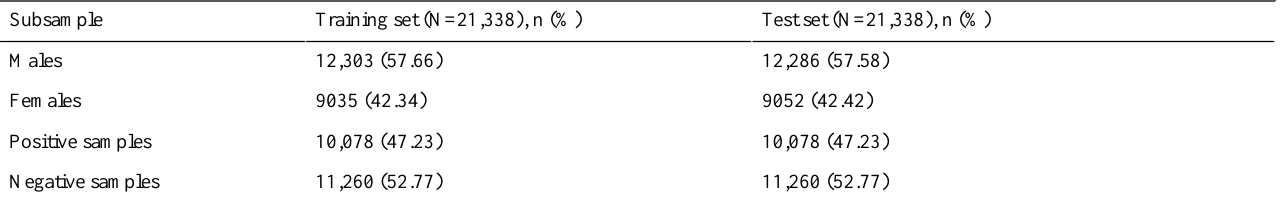
Table 1. Sample distribution of the training and test